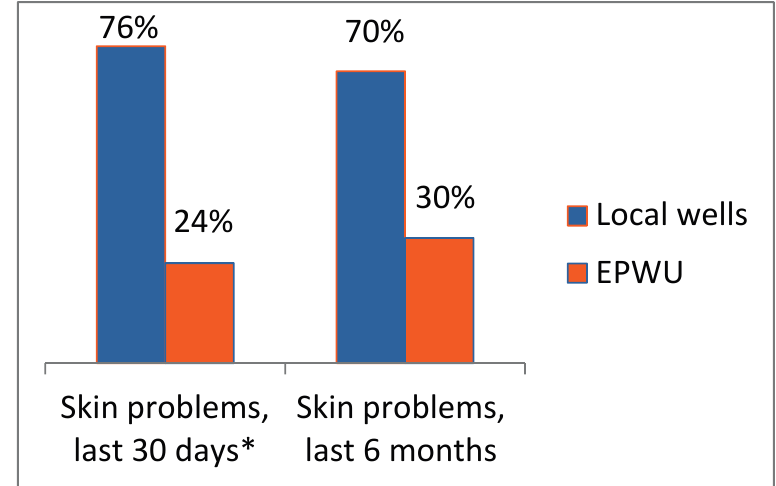
Figure 5. Prevalence of skin problems in relation to water source. * Significant difference between water sources using chi-square test, p = 0.04 (x 2 =